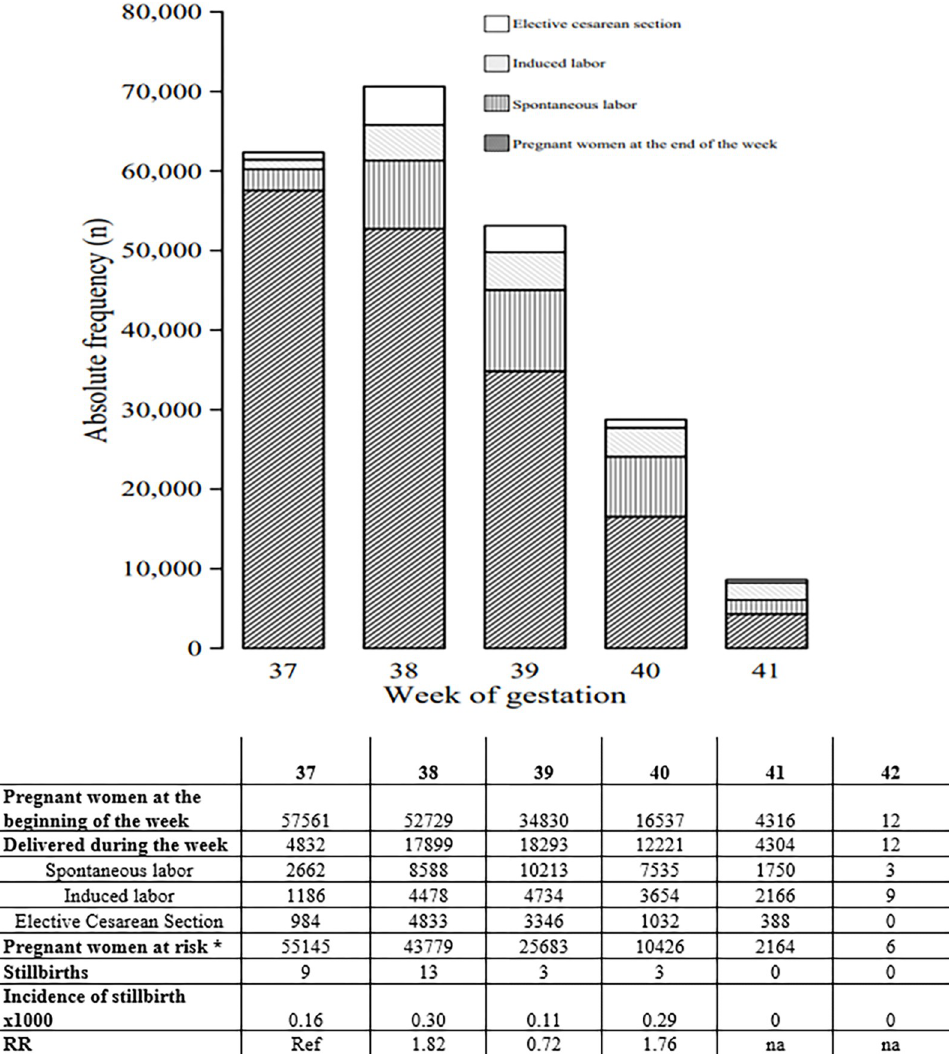
Fig 2. Number of cases per week of gestation according to clinical management: Spontaneous labor, cesarean section prior to labor, induced labor, expectant management.